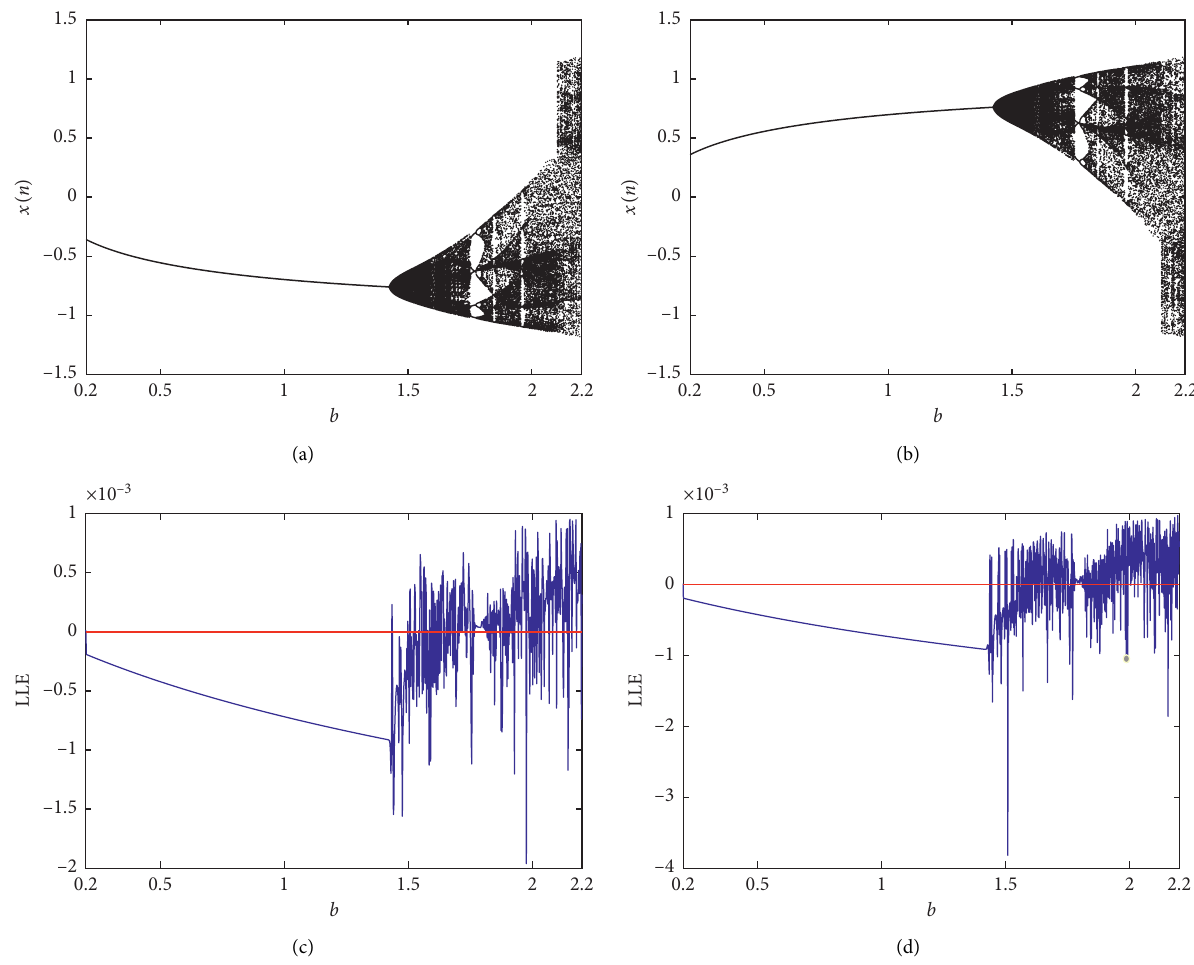
Figure 1: Bifurcation diagrams and corresponding LLE spectrums for the map with different initial values as the parameter b varies: (a) the bifurcation diagram with x